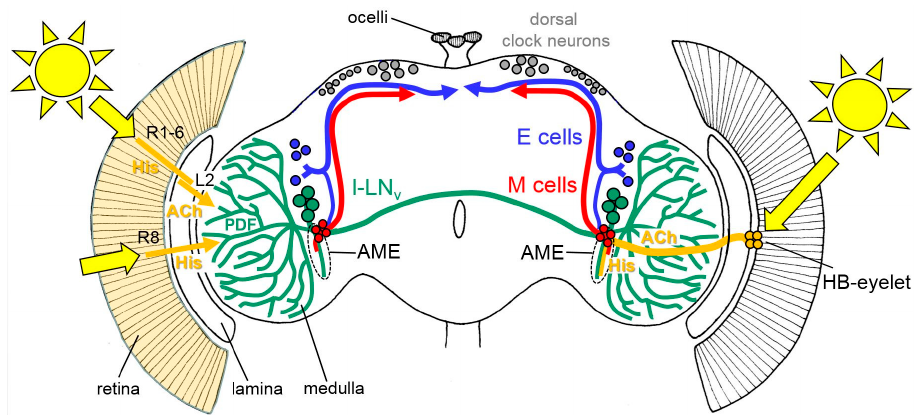
Figure 2. Rough schematic representation of light input through the compound eyes (left) and the Hofbauer-Buchner (HB)-eyelets (right) to the circadian lateral clock neurons (the M cells, E cells, and the large ventrolateral neurons (l-LN v )). All receptor cells of the compound eyes use histamine (His) as a neurotransmitter, whereas the HB-eyelets utilize histamine and acetylcholine (ACh). The HB-eyelets project into the accessory medulla (AME); they signal via histamine to the l-LN v , which in turn contain the neuropeptide PDF (Pigment-dispersing Factor) and via ACh to the M cells. Receptor cells 1 to 6 (R1-6) signal via the His to the lamina monopolar cells (L2). L2 cells express ACh and signal in the distal medulla to the l-LN v . Rh6-positive receptor cells 8 (R8) may play an integrative role in the light input from all other receptor cells but it is still unknown how they signal to the circadian clock neurons, since they are not directly connected to the l-LN v [53]. The other receptor cells are omitted for clarity. For details, see text.